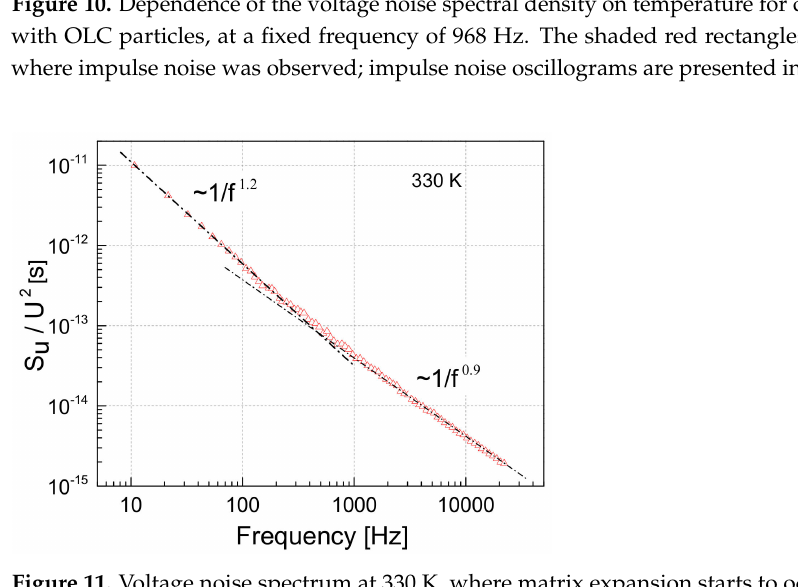
Figure 11. Voltage noise spectrum at 330 K, where matrix expansion starts to occur, for the sample with 7 wt.% of 40 nm OLC